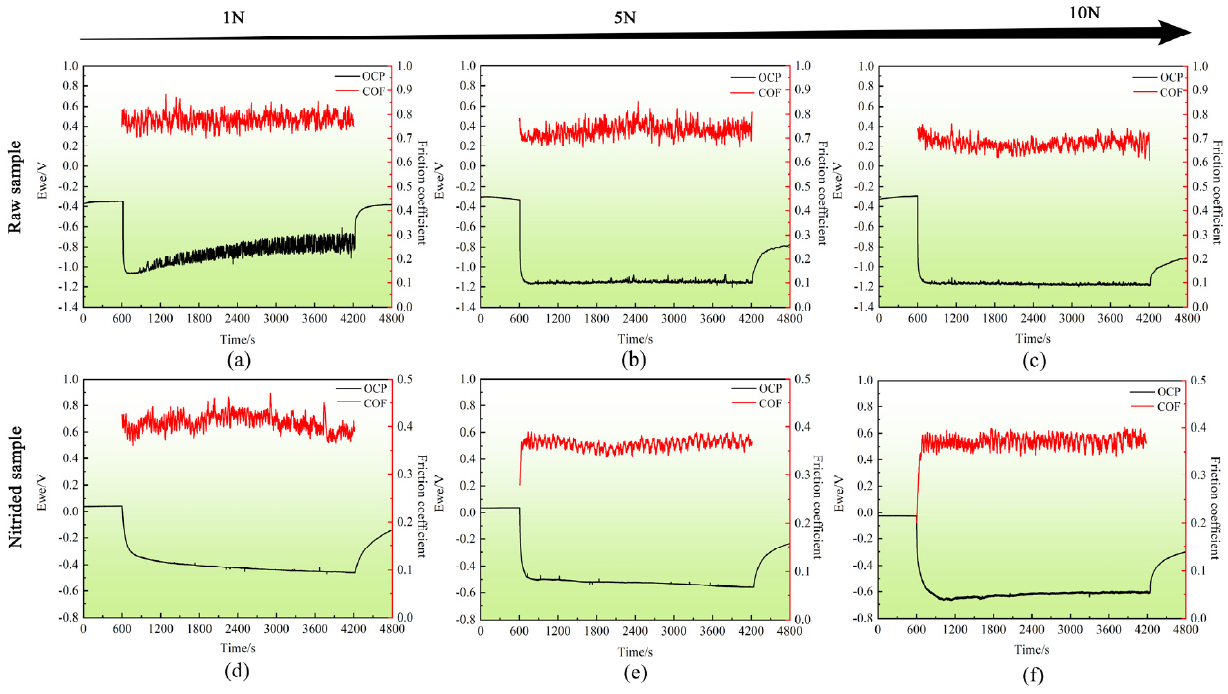
Figure 4. Time evolution of the coefficient of friction (COF) and the potential (OCP) during the tribocorrosion test of the raw sample and the nitrided samples in SBF solution for ( a – c ) Raw samples; ( d – f ) Nitrided samples.